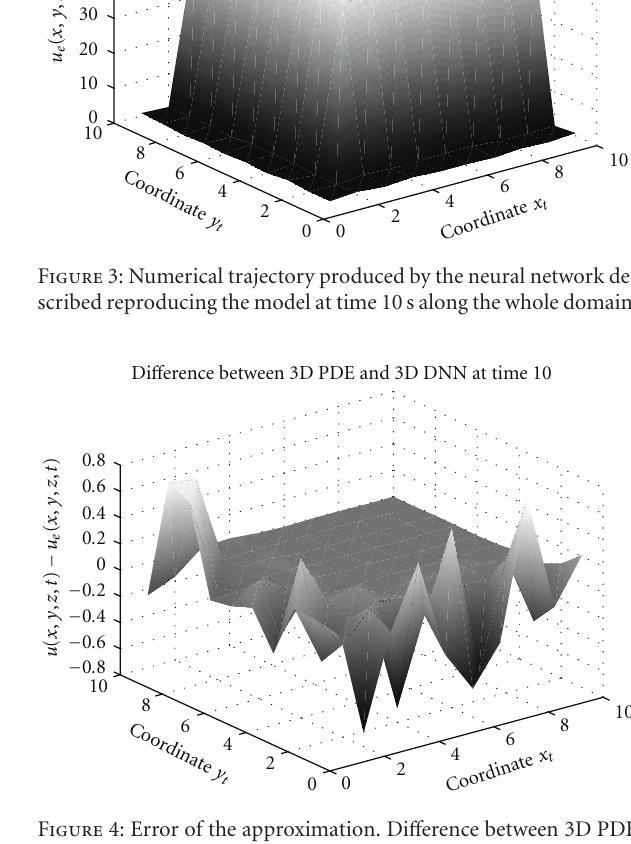
Figure 4: Error of the approximation. Di ff erence between 3D PDE numerical solution and 3D DNN approximation at time 10 s along the whole